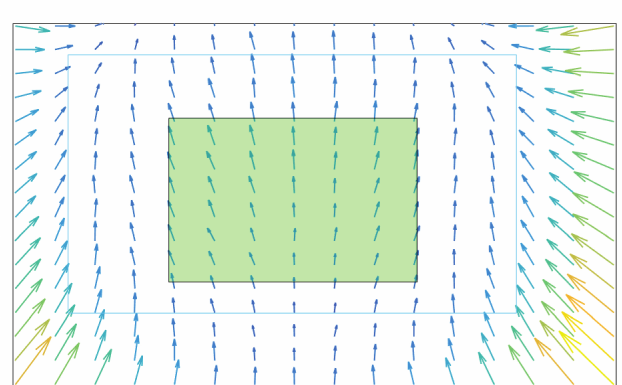
Figure 16 . An example of error pattern in the image when having mapping error and parallax error combined